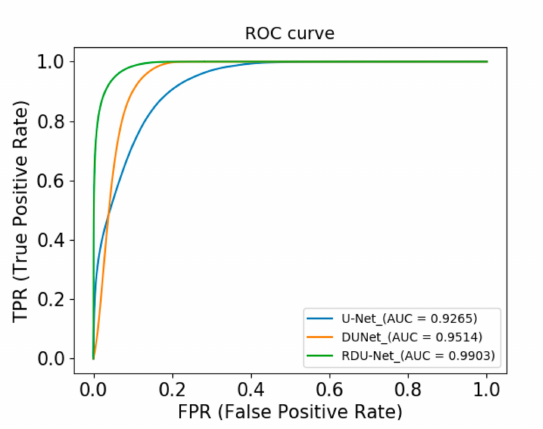
Figure 11. ROC curves of three models.